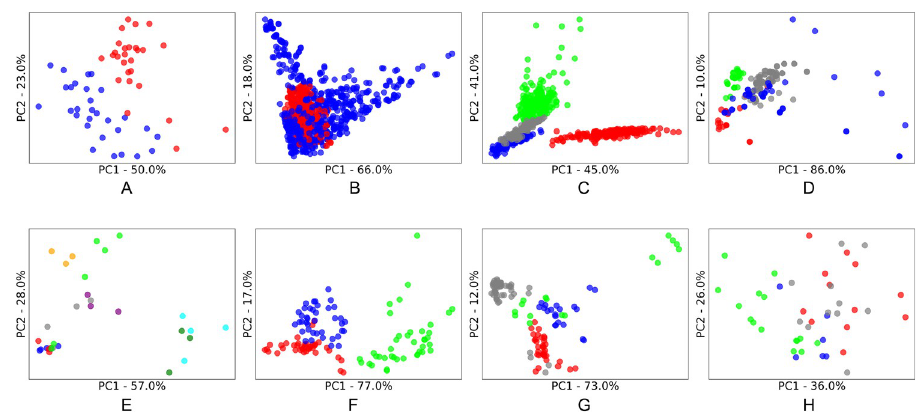
Fig 3. PC1 vs PC2 PCA score plots of the clusters present in the public spectroscopy datasets. A: Coffee; B: Fruit; C: Liver; D: Mangos; E: Marzipan; F: Meats; G: Olive Oil; H: Wine. The percentage of original information contained in each principal component is shown on each axis.